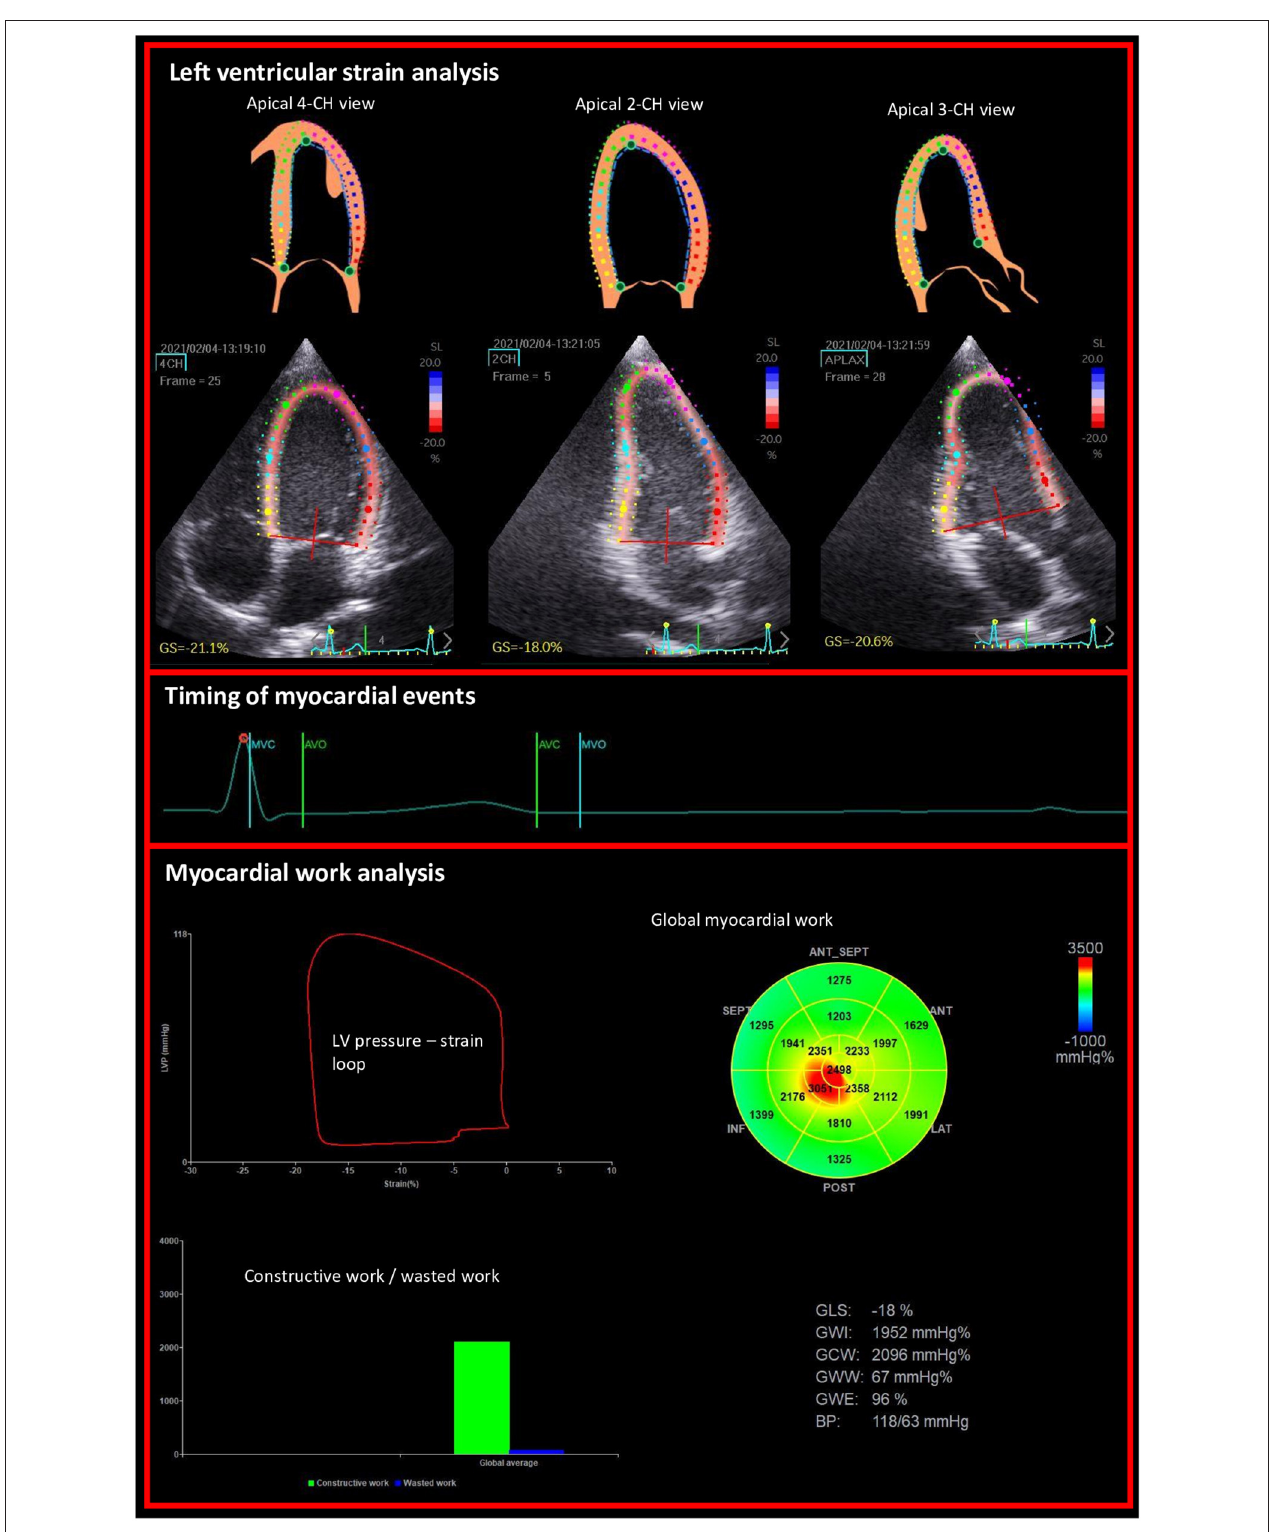
FIGURE 1 | Example of non-invasive estimation of the LV myocardial work from the left ventricular longitudinal strains on apical views and the timing of mitral and aortic valve events.